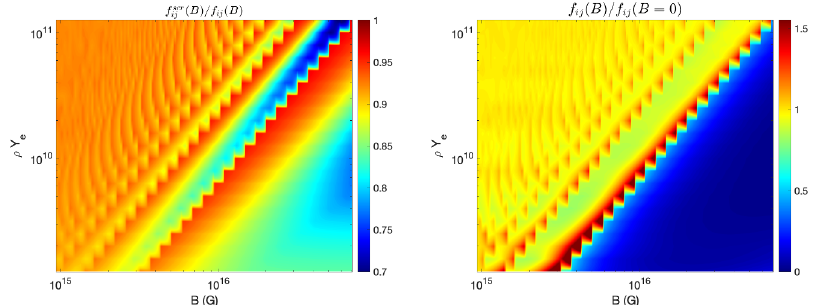
Figure 1. The left panel: The ratio between screened and unscreened f ij . For the field-free situation, only a few percent deviations of f ij could be found (i.e., left-upper region of this panel). For the high field and relatively low-density case ( B > 10 16 G and ρ Y e ∼ 10 9 ), the screening e ff ect could suppress f ij about 20%. The right panel: The f ij in a background magnetic field compared with a field-free case. f ij could be enhanced about 1.5 times when the field strength just corresponds to a new popped-up Landau level. For the extremely high field case, only the LLL is allowed for the electrons to be occupied in, then f ij is drastically reduced (i.e., left-upper region of this panel). The calculation here sets T = 10 GK. This figure is taken from [8].